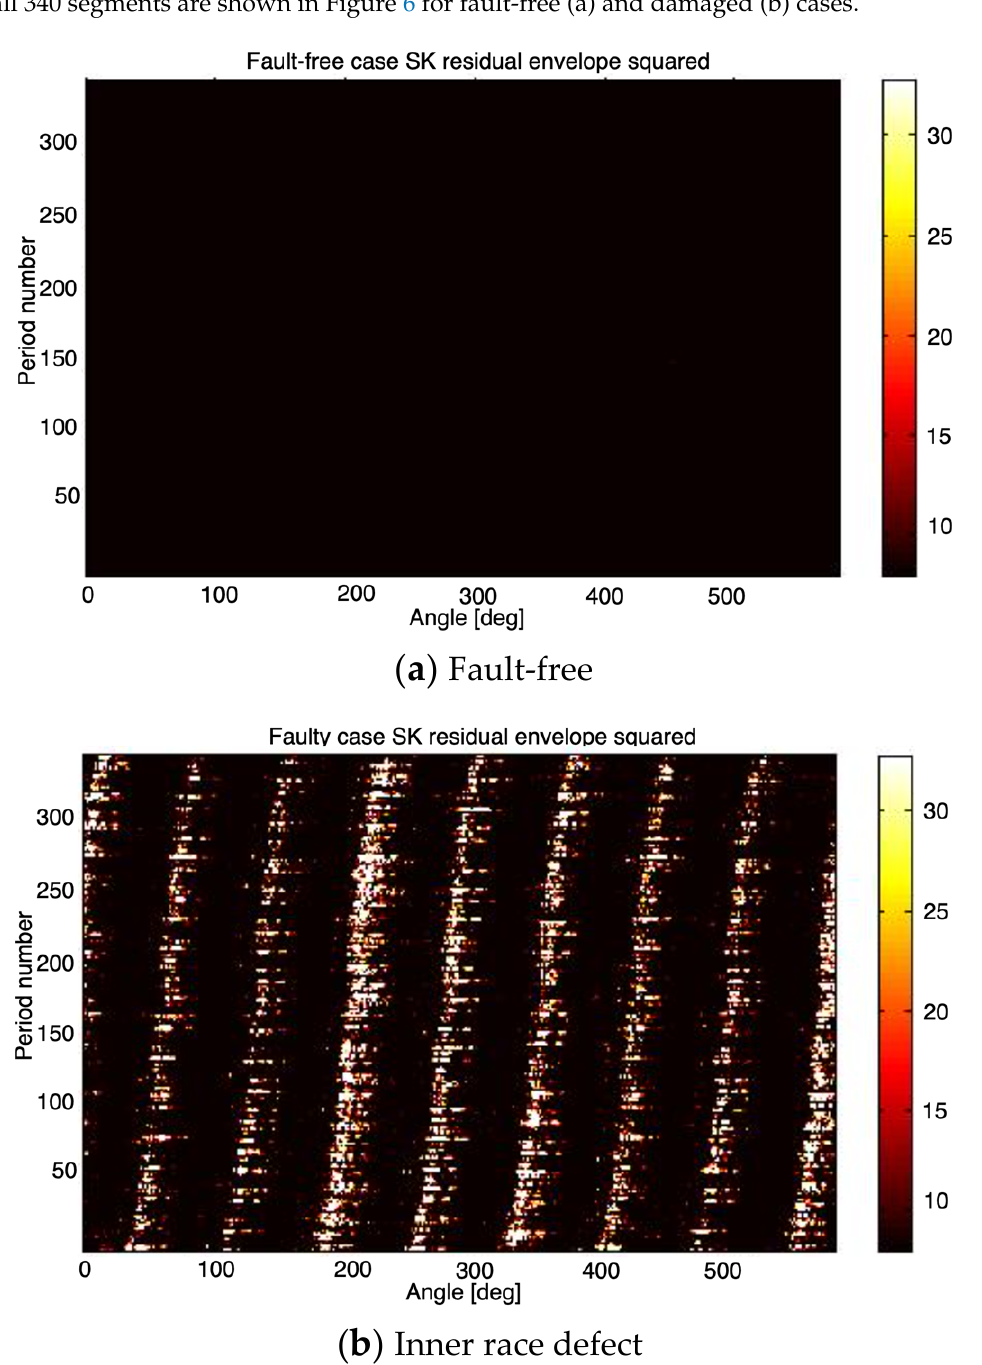
Figure 6. The diagnostic features—squared envelope of the SK-filtered signal. The feature maps show mainly low amplitude (<10) apart from the high amplitude features in damaged case (b) due to extracted impulsive components. The diagnostic features have high amplitudes at the moment of the impact and low amplitudes